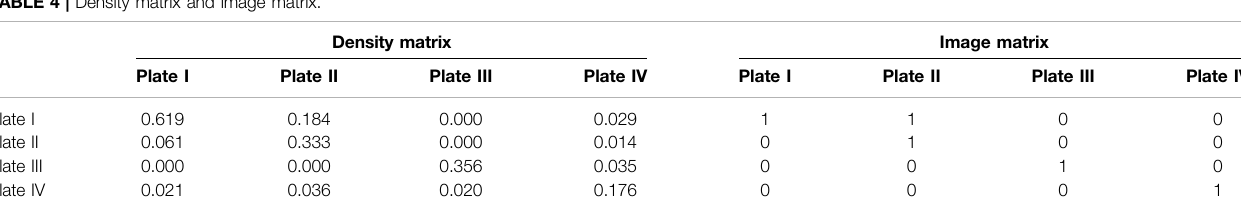
TABLE 4 | Density matrix and image